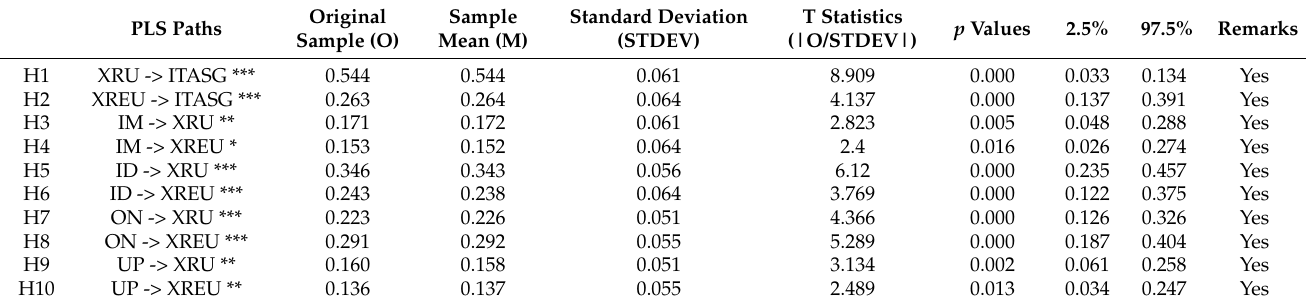
Table 7. The outcome of the Structural Model